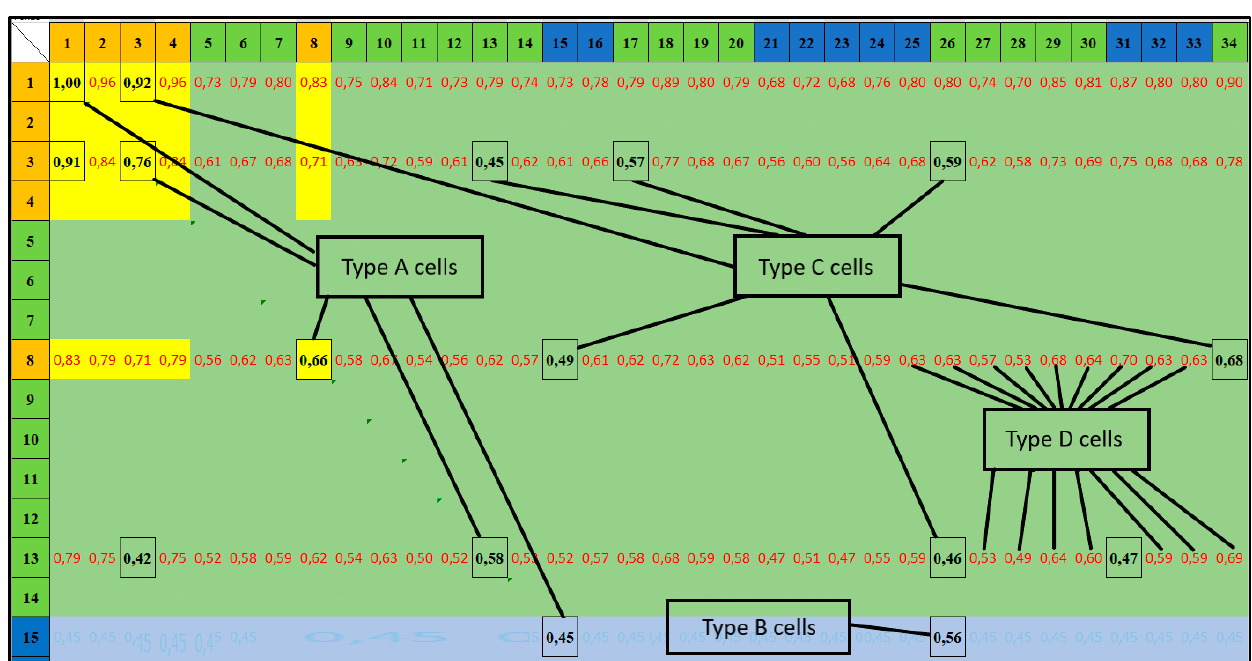
Figure 4. An excerpt from the Excel spreadsheet of the normalized aesthetic appeal values of the immediate and foreground habitat combinations of coastal forests and dunes. (Drawn by Arvydas Urbis).